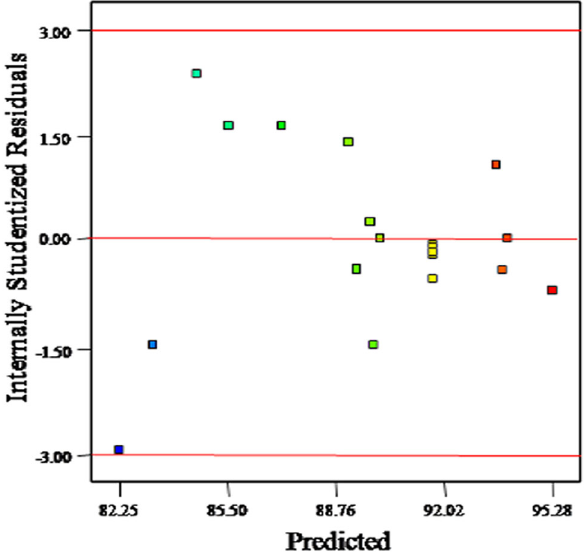
Fig. 5 The predicted CO 2 removal efficiency (%) and studentized residuals plot